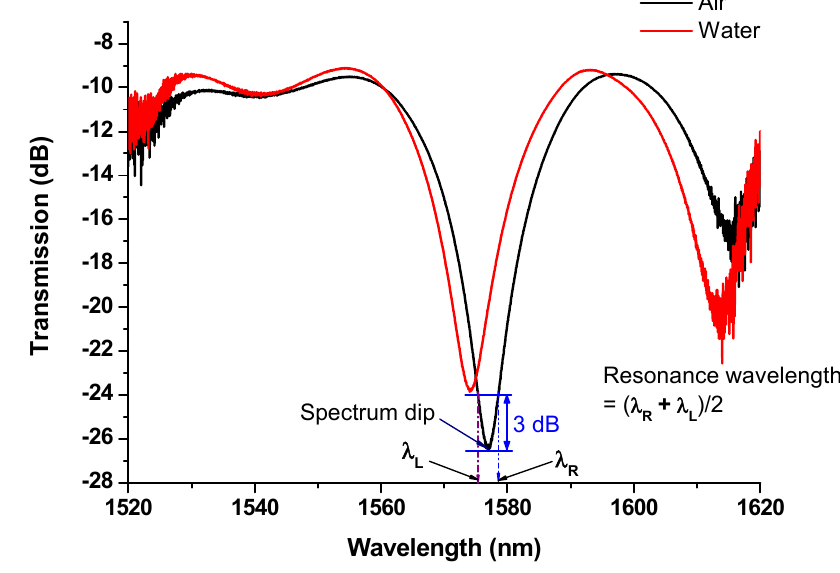
Figure 2. The typical transmission spectra of a CO immersed in water and the resonance wavelength (1,577.06 nm) was obtained with 3-dB bandwidth